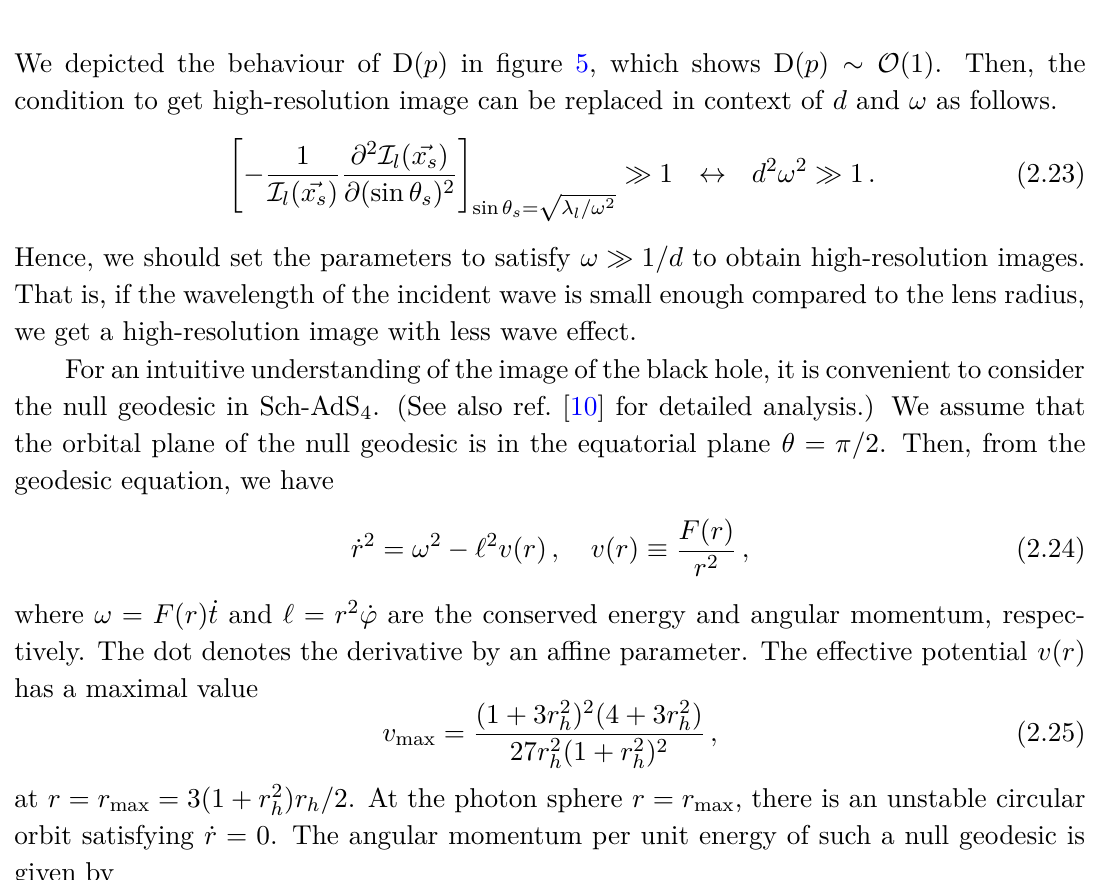
Figure 4 . The behaviour of I ( ~x s ) for d = 0 . 5 , ω = 80 , and l = 20 , 40 , 80 . The dashed lines √ represents θ s = arcsin λ l /ω .